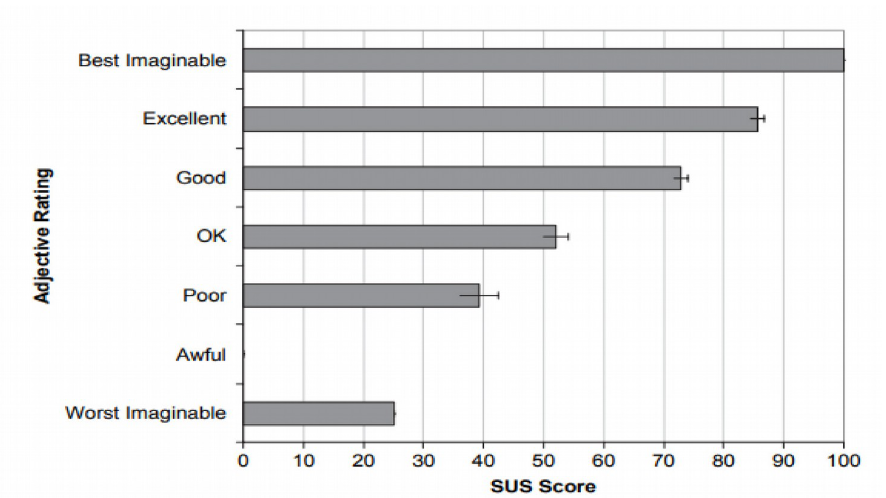
Figure 3. Mean system SUS scores rating (Bangor et al., 2008)